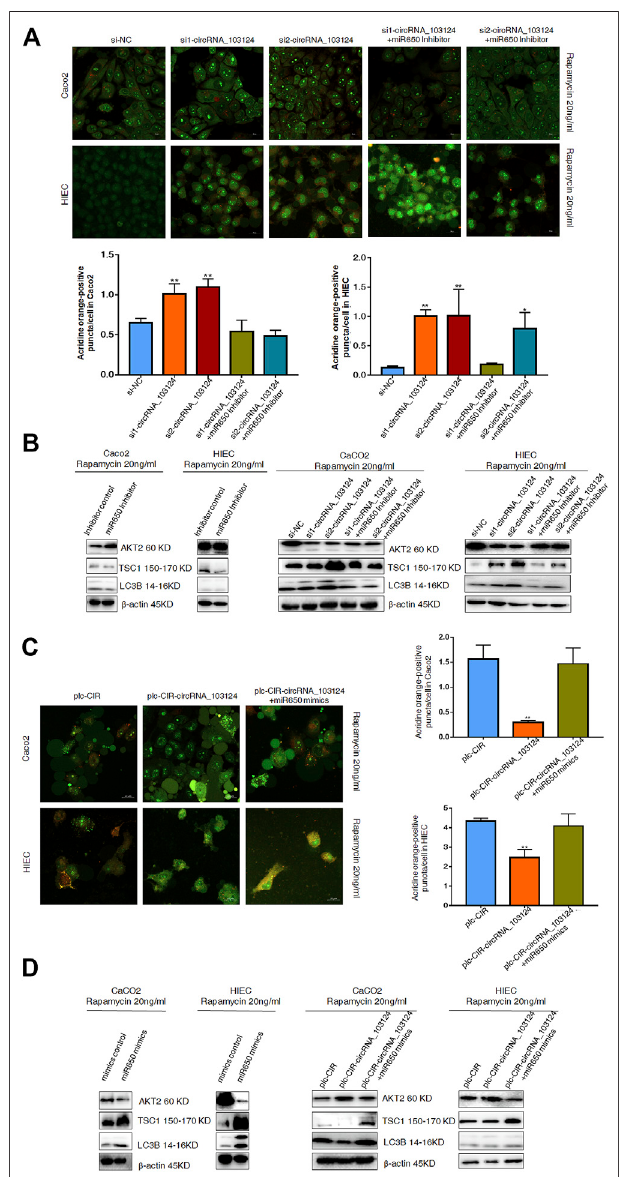
FIGURE 6 | Hsa-miR-650 rescued the inhibitory effects on autophagy induced by hsa_circRNA_103124 overexpression. (A) Autophagy was inducedbyrapamycin(20 ng/ml)inHIECsandCaco2followingtransfectionof thehsa_circRNA_103124siRNA.Fluorescentimagesofacridineorange (AO) positive cells (in orange) were acquired using a confocal laser scanning microscope.Theproportion ofpositivelystainedcells(orange)thatunderwent autophagy was calculated relative cells stained green. (B) Relative expression of AKT2, TSC1 and LC3B was detected using western-blotting and normalized to β -actin. si-NC, cells transfected with negative control of hsa_circRNA_103124 siRNA. si1-circRNA_103124, si2-circRNA_103124, cells transfected with the hsa_circRNA_103124 siRNA; si1-circRNA_103124 + miR650 Inhibitor, si2-circRNA_103124 + miR650 Inhibitor, cells cotransfected with hsa_circRNA_103124 siRNA and hsa-miR-650 inhibitor. Inhibitor control, cells transfected with the negative control of hsa-miR-650 inhibitor. miR650 Inhibitor, cells transfected with hsa-miR-650 inhibitor. (C) Autophagy was induced by rapamycin (20 ng/ml) in HIECs and Caco2 cells following hsa_circRNA_103124 overexpression. Fluorescent images of AO- ( Continued )